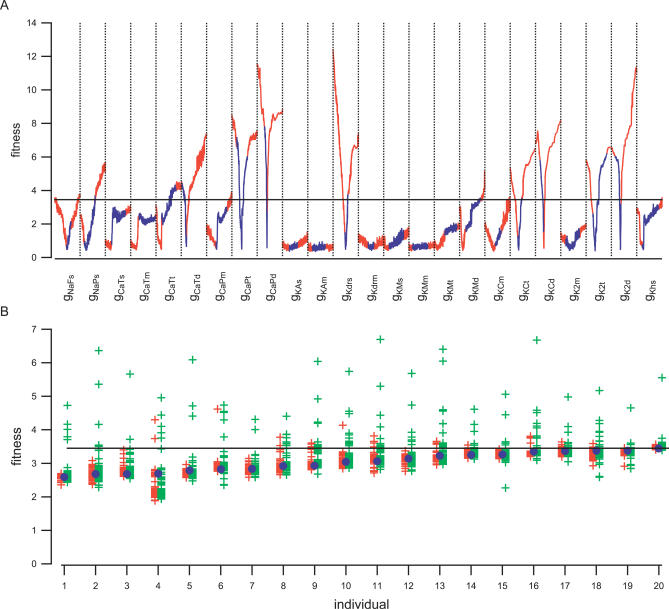
Points of the Parameter Space around the Data and the Selected Individuals(A) Fitness of 24 × 500 points for which all the parameters are equal to that of the data but one, labeled on the abscissa, and varied randomly in the full allowed range (see Table 1). The mean ± sdv range covered by the 20 selected individuals is shown in blue for each conductance density. The exact data value is never randomly selected so none of the distributions reached the perfect fitness value of 0.(B) For each of the 20 selected individuals (blue dots), the fitness of the 48 individuals obtained by changing its parameters by ±1% (red) or ±5% (green). Only one parameter is changed at a time.